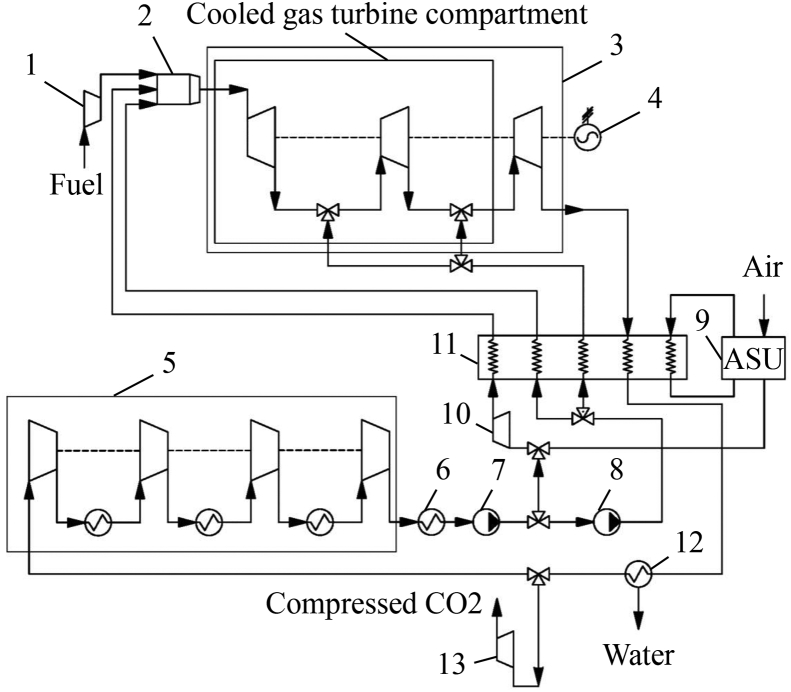
The NET Power cycle.